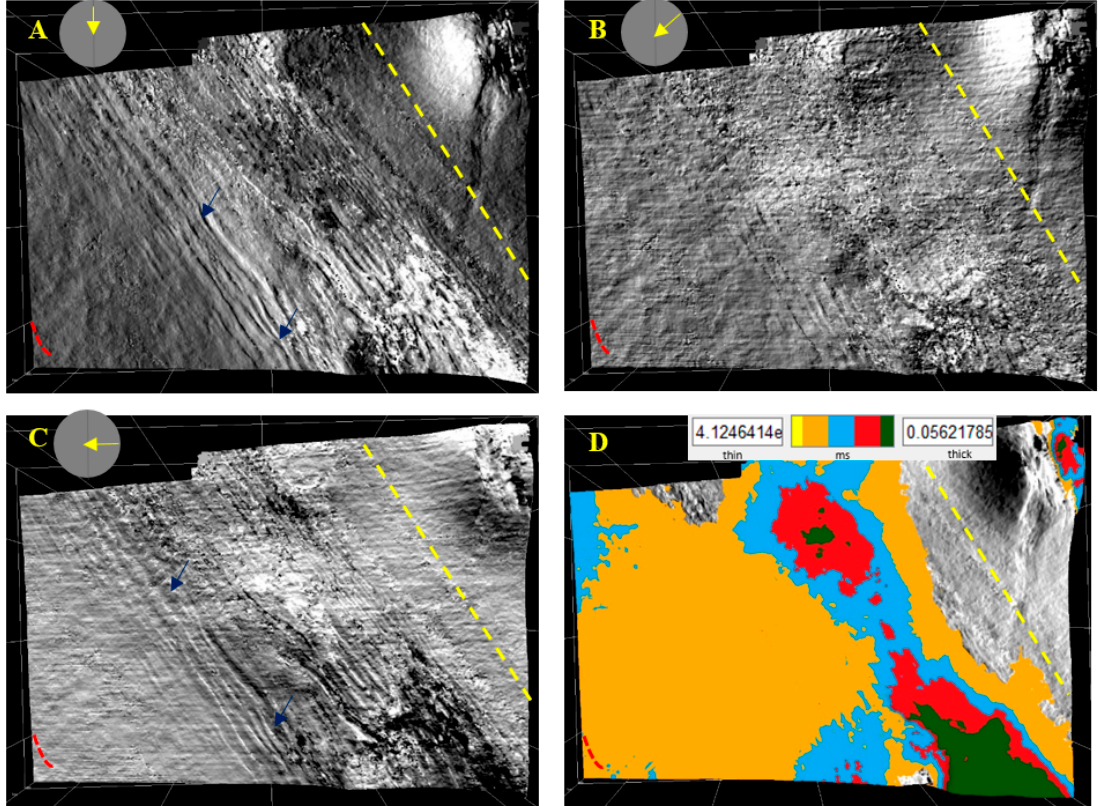
Figure 14. The apparent dip attribute for MRS1 surfaces at ( A ) 0°, ( B ) 45°, ( C ) 90°, and ( D ) the Isopach map. The blue arrows indicate the redevelopment of sand waves towards the basin-ward region.